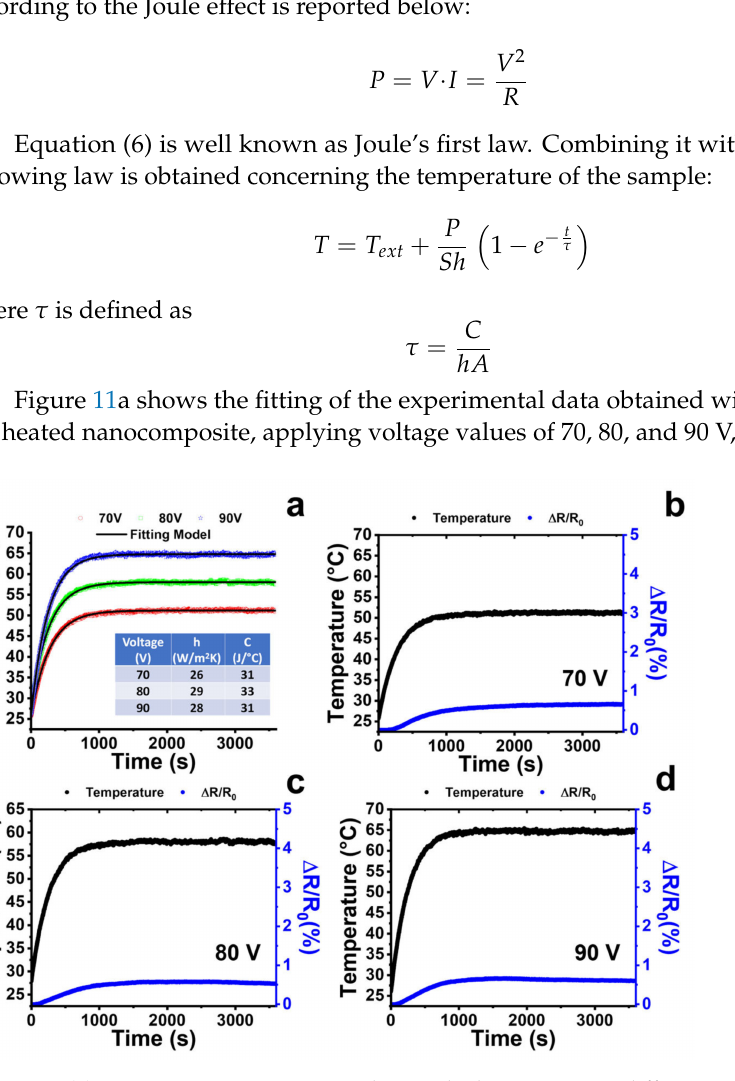
Figure 11. ( a ) Temperature against time during the heating test at different applied voltage values (70, 80, 90 V): symbols depict experimental data and lines depict the fitting model by Equation (7). Temperature behavior (on the left vertical axis) and resistance variation (i.e., ∆ R/R 0 on the right vertical axis) during the heating time at an applied voltage value of ( b ) 70 V; ( c ) 80 V; ( d ) 90